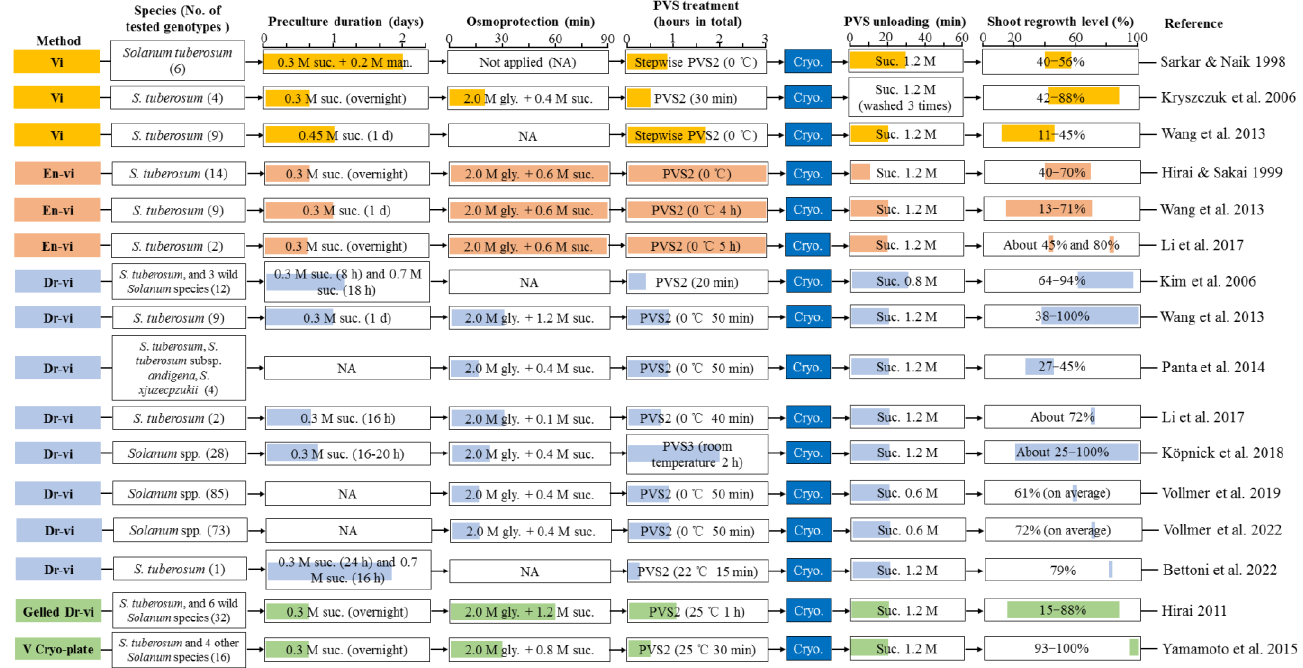
Figure 1. Comparison of major steps of various vitrification solution-based methods for shoot tip cryopreservation in potato [56,68,107,108,118,123,124,129 – 134]. Abbreviations: gly, glycerol; man, mannitol; PVS, Plant vitrification solution; suc, sucrose.